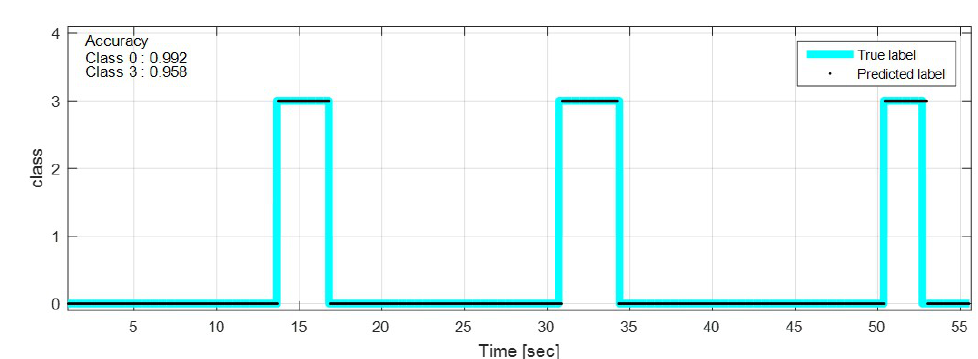
Figure 17. Prediction result on bump road, 10 km/h.